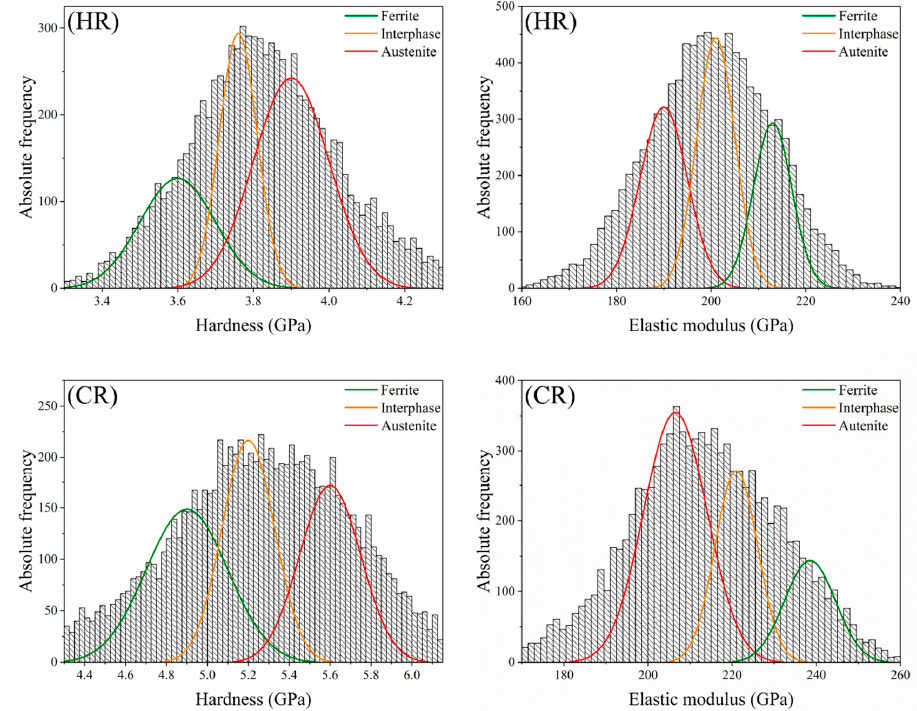
Figure 9. H and E histograms with bin sizes of 25 MPa and 1.5 GPa respectively, evaluated from 10,000 indentations for HR and CR samples studied.